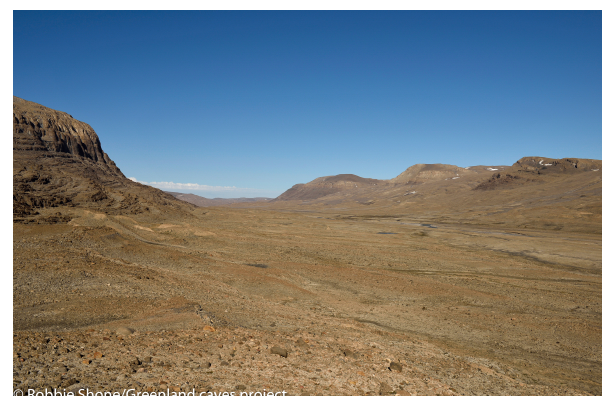
Figure 2. Photograph from the arid study region near to the loca- tion of the caves, © Robbie Shone/Greenland Caves Project (Au- gust